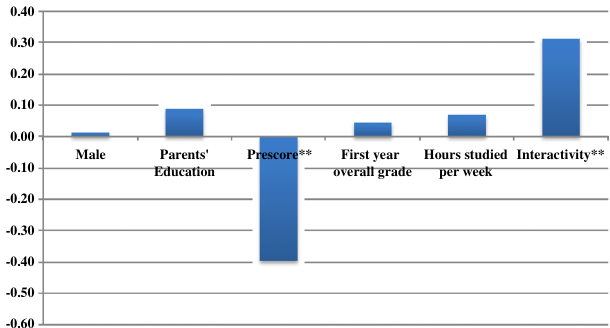
FIG. 2 (color online). Standardized coefficients for model 3 with CSEM gain as the dependent variable (from Table IV) (* p < 0 : 05 , ** p < 0 : 01 ).